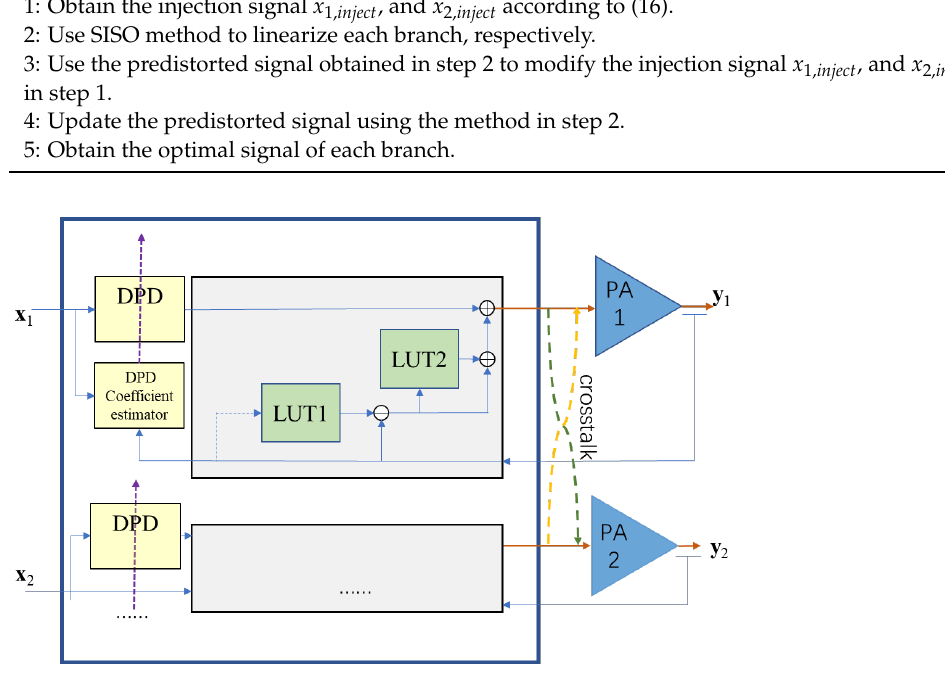
Figure 3. Block diagram of the proposed DPD solution.